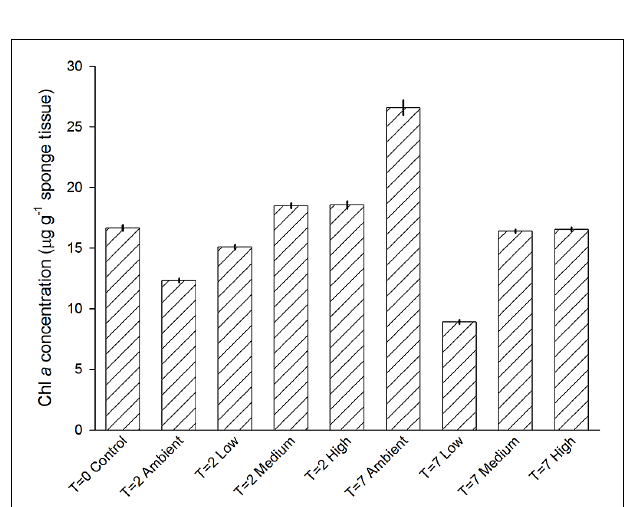
FIGURE 7 | Mean ( ± SE) concentration of Chl a in C. stipitata individuals from each treatment ( n = 3 for